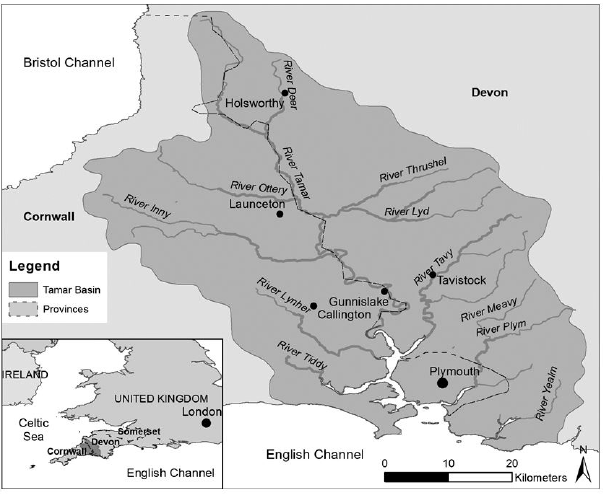
Fig. 1 . The Westcountry Rivers Trust operational area (source: Ron Wundering; Huitema and Meijerink